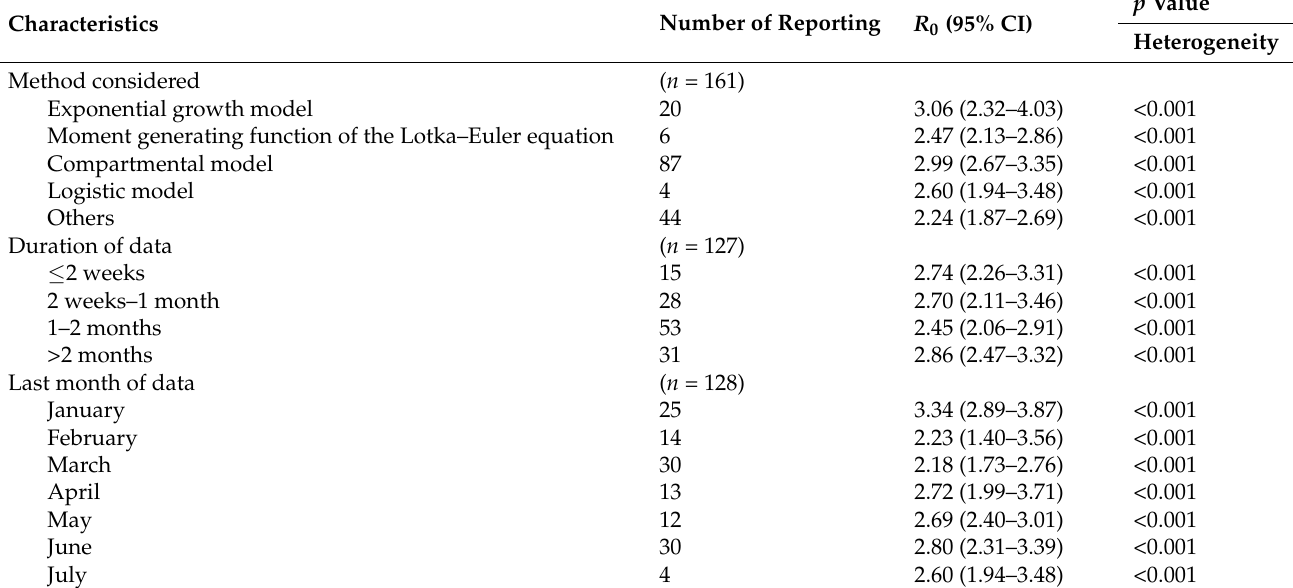
Table 1. Sub ‐ group analysis for basic reproduction number ( 𝑅 (cid:2868) ) based on a random effects model